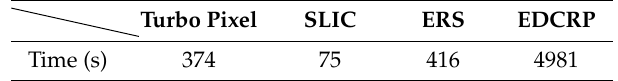
Table 7. The running time of different approaches for image